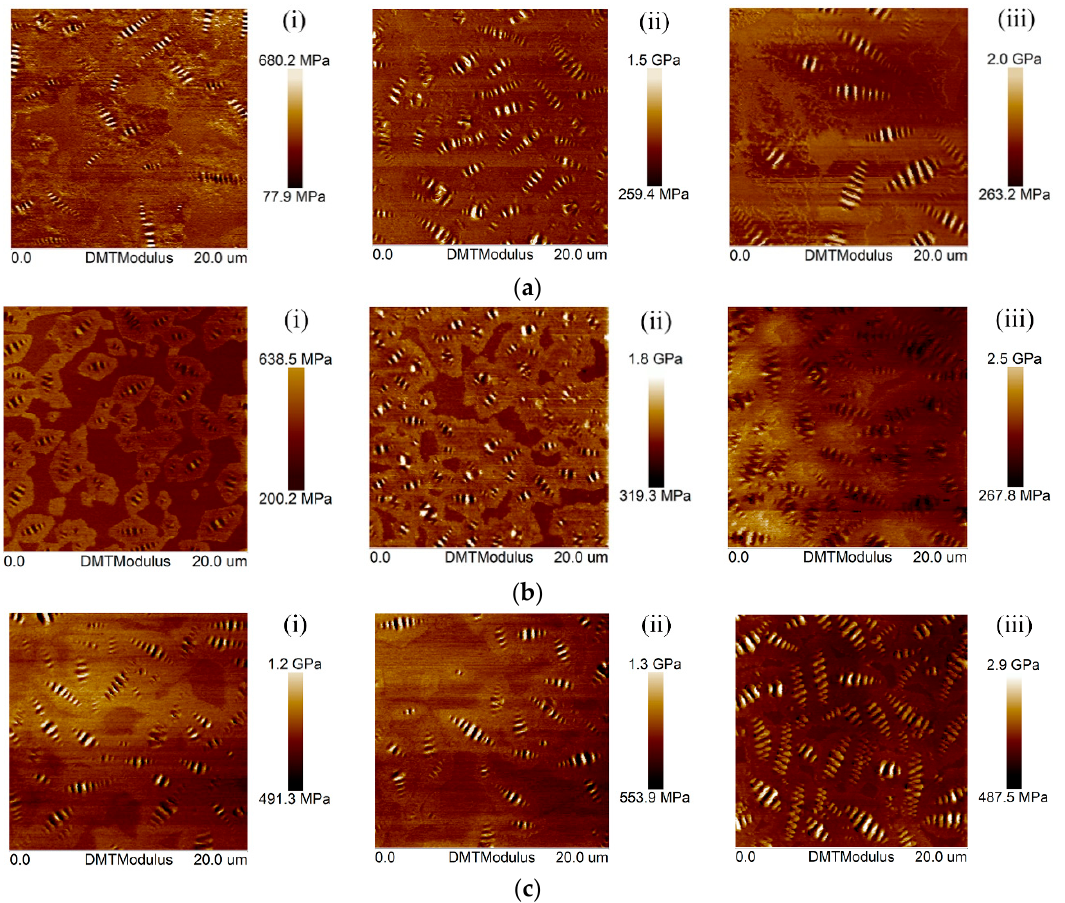
Figure 3. Derjaguin-Muller-Toporov (DMT) modulus of bitumen specimens before and after aging: ( a ) 70# bitumen; ( b ) 50# bitumen; ( c ) 30# bitumen, for ( i ) Virgin; ( ii ) RTFO-aged; ( iii ) Table 2. Structural similarity index (SSIM) values between the topographic image and the DMT modulus image of different bitumen before and after aging.